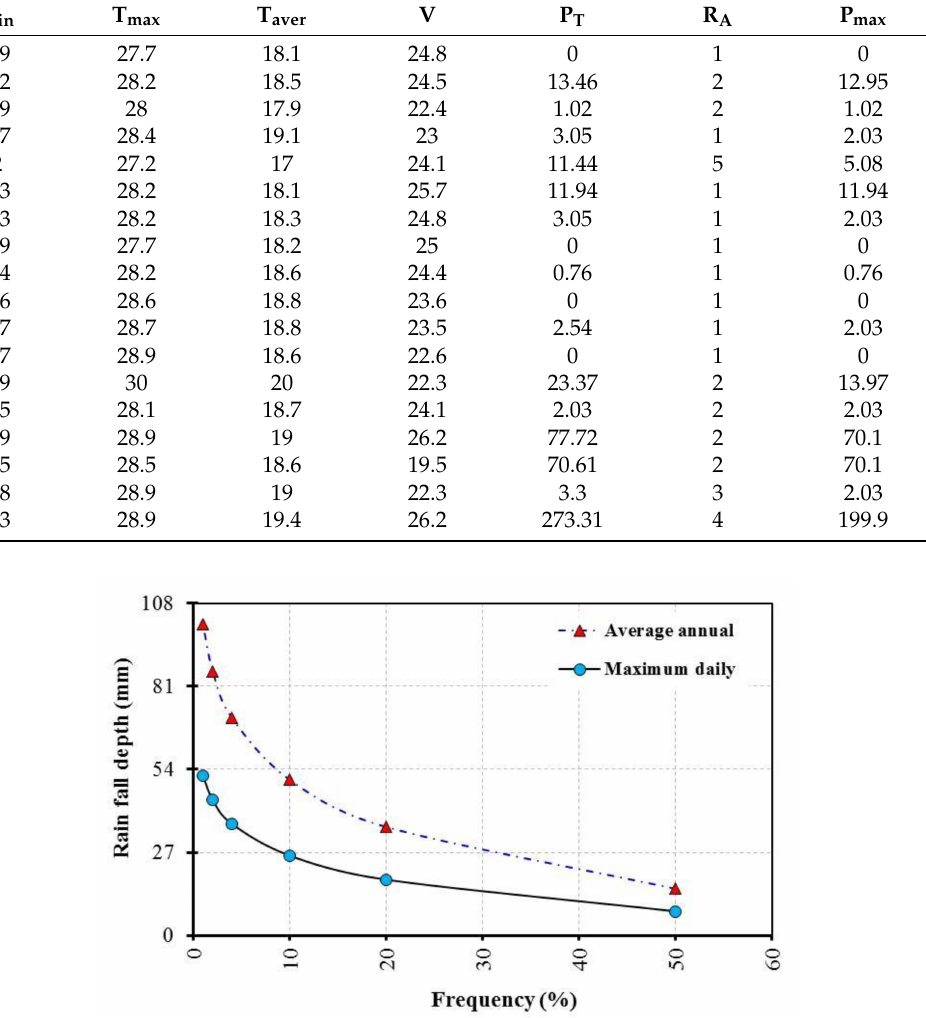
Table 1. Historical climate data form weather of El Tur station.